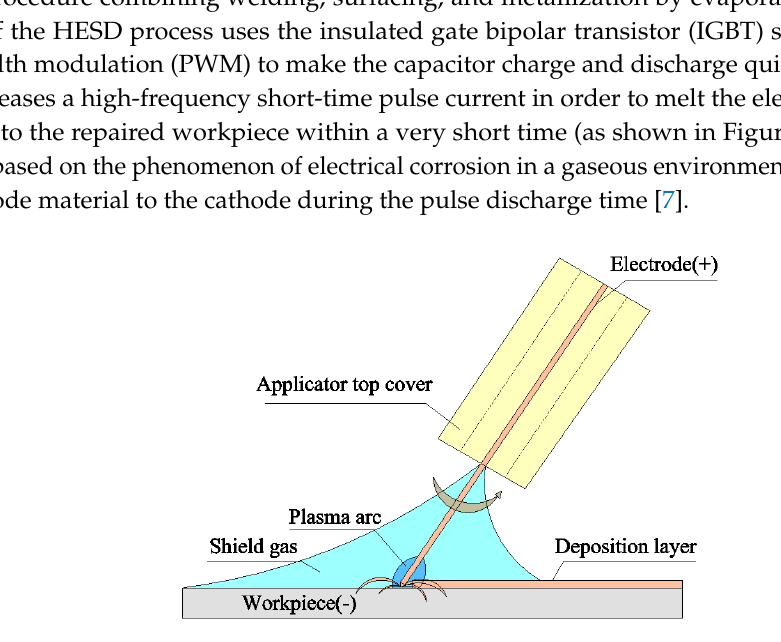
Figure 1. Schematic of the HESD process.